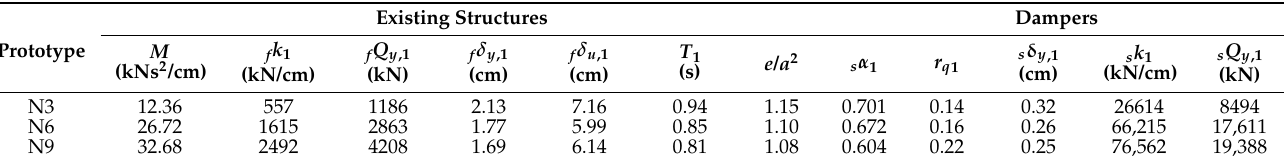
Table 3. Properties of the existing structure and of the hysteretic